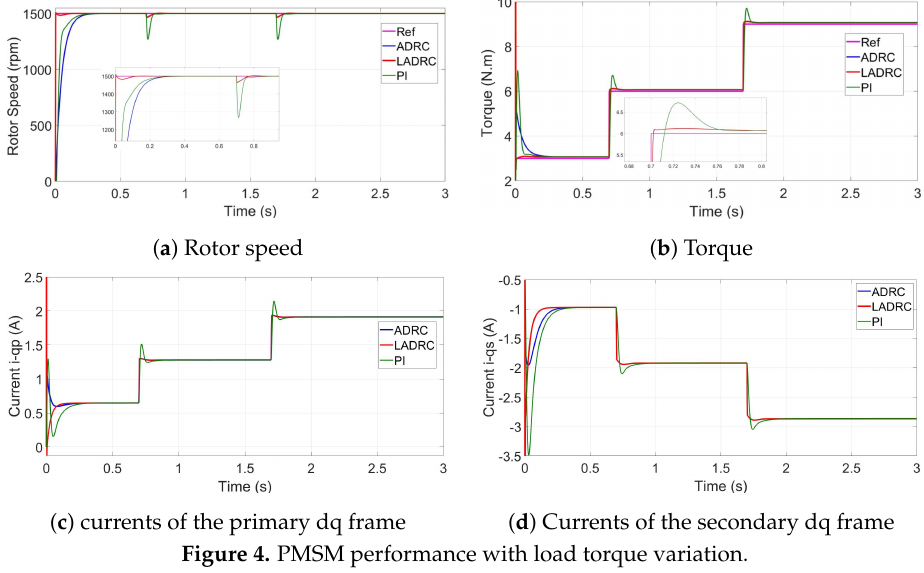
Figure 4. PMSM performance with load torque variation.